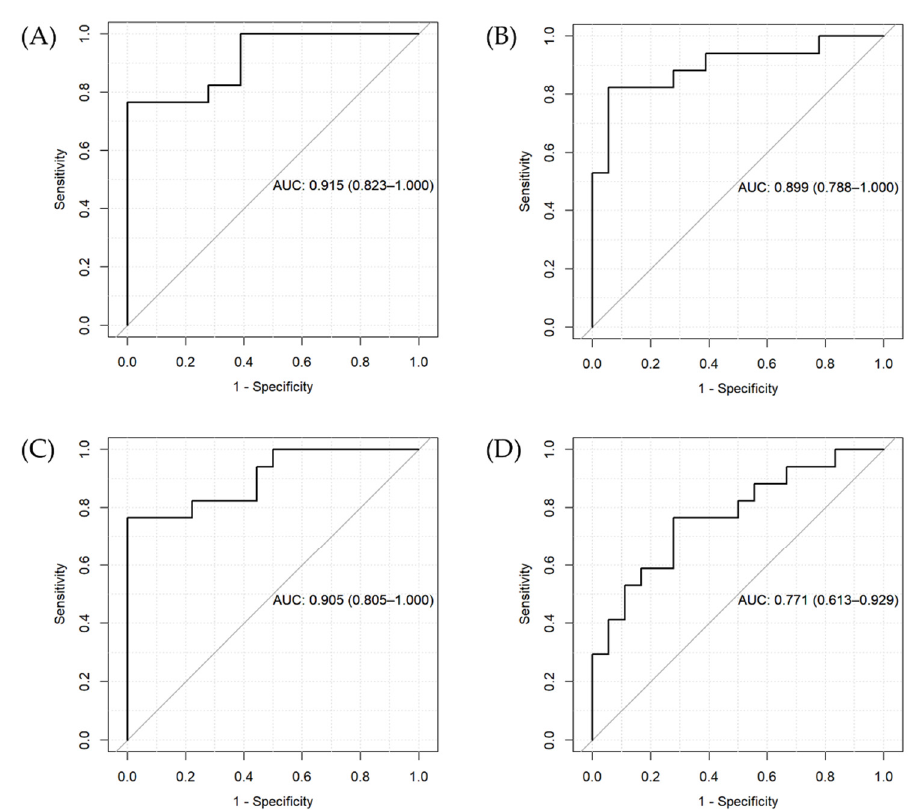
Figure 2. ROC curves and AUC for the penalized regression models. ( A ) Ridge regression for Model 1 (including metabolite levels, age, gender, and BMI), ( B ) ridge regression for Model 2 (including variables in Model 1 + genetic variants), ( C ) LASSO regression for Model 1, and ( D ) LASSO regression for Model 2.